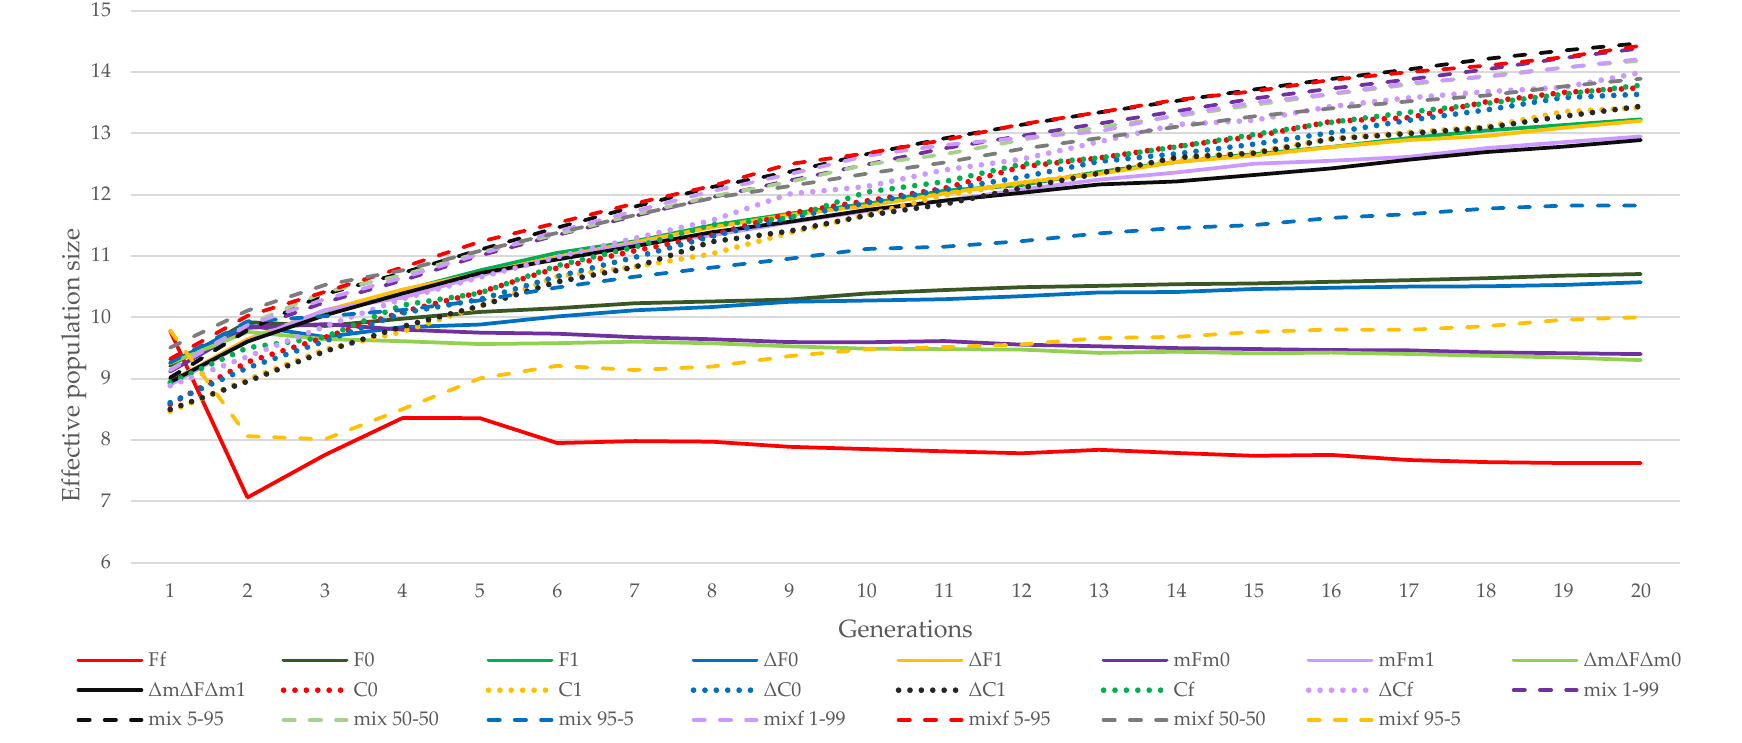
Figure 4. Evolution of effective population size obtained by the different strategies in the reference population of La Lajita throughout 20 generations. (Ff, F0, and F10 based on minimum coancestry of the parents; ( ∆ F0 and ∆ F1) based on increment in coancestry of the parents; (mFm0 and mFm1) based on weighted coancestry; ( ∆ m ∆ F ∆ m0 and ∆ m ∆ F ∆ m1) based on weighted increase in coancestry; (C0, C1, and Cf) based on coancestry of the offspring; ( ∆ C0, ∆ C1, and ∆ Cf) based on increase in coancestry of the offspring; (mix 1–99, mix 5–95, mix 50–50, mix 95–5, mixf 1–99, mixf 5–95, mixf 50–50, and mixf 95–5) mixing information from the parents’ coancestry and offspring’s coancestry.